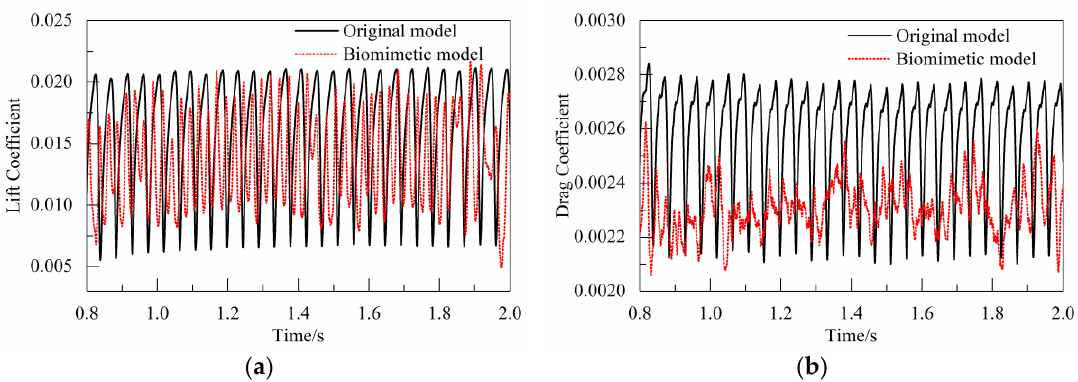
Figure 10. Comparison of aerodynamic force coefficients of the original hydrofoil and biomimetic hydrofoil: ( a ) lift coefficient; ( b ) drag coefficient.